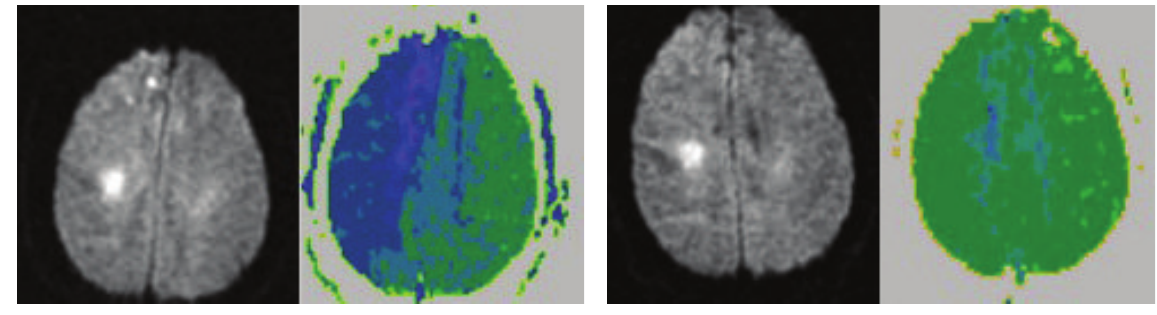
Figure 2: (a) Diffusion-weighted image (DWI; left), showing small subcortical infarct and perfusion-weighted image (PWI; right) of a patient with severe viewer-centered neglect at Day 1. (b) DWI and PWI of the same patient at Day 3, after viewer-centered neglect recovered, as indicated by recovery of detecting stimuli on the left and copying stimuli on the left of a scene. PWI shows that reperfusion of the right frontoparietal cortex was associated with recovery of viewer-centered neglect. In this case, reperfusion was brought about with induced blood pressure